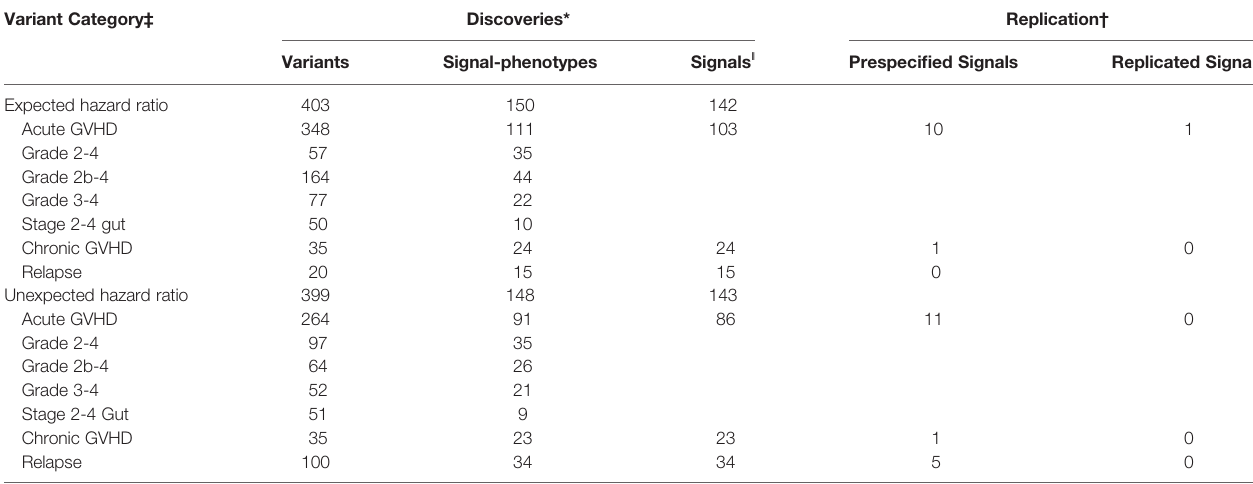
TABLE 4 | Discovery and replication of MHC-agnostic recipient allele mismatch associations. Variant Category ‡ Discoveries* Replication † Variants Signal-phenotypes Signals ‖ Prespeci fi ed Signals Replicated